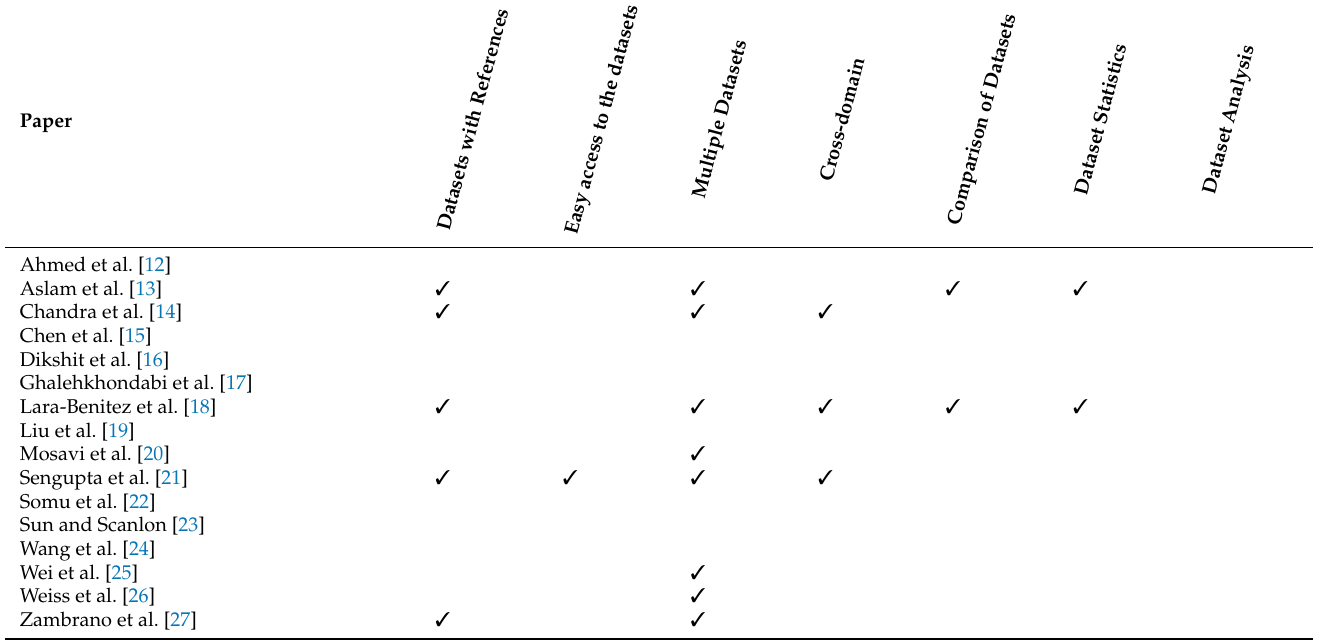
Table 1. This table compares how the extracted surveys identified in this paper analyzed time series datasets. The tick indicates if the corresponding publication met the condition of the